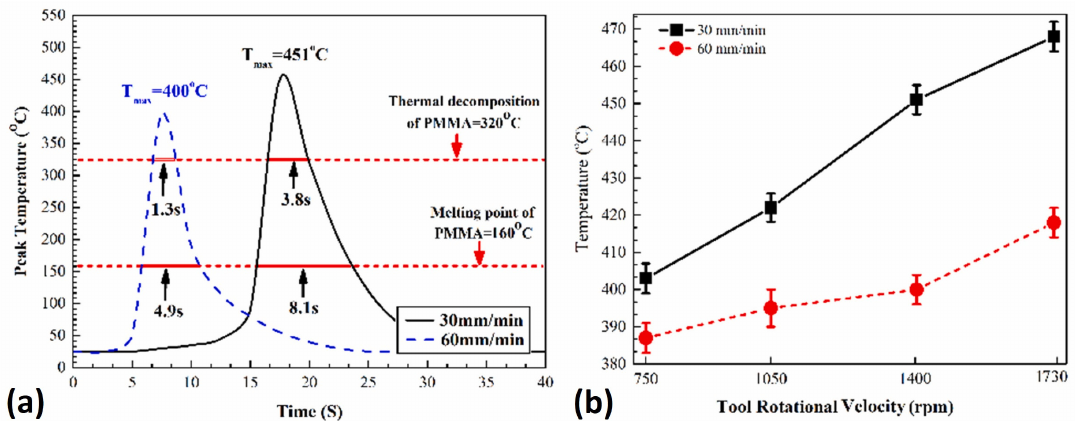
Figure 13. ( a ) Temperature variation for the aluminium/PMMA joint; ( b ) relation between tool rotational velocity and peak temperature. Reprinted with permission from Ref. [74]. 2019, H.A. Derazkola, A. Simchi.